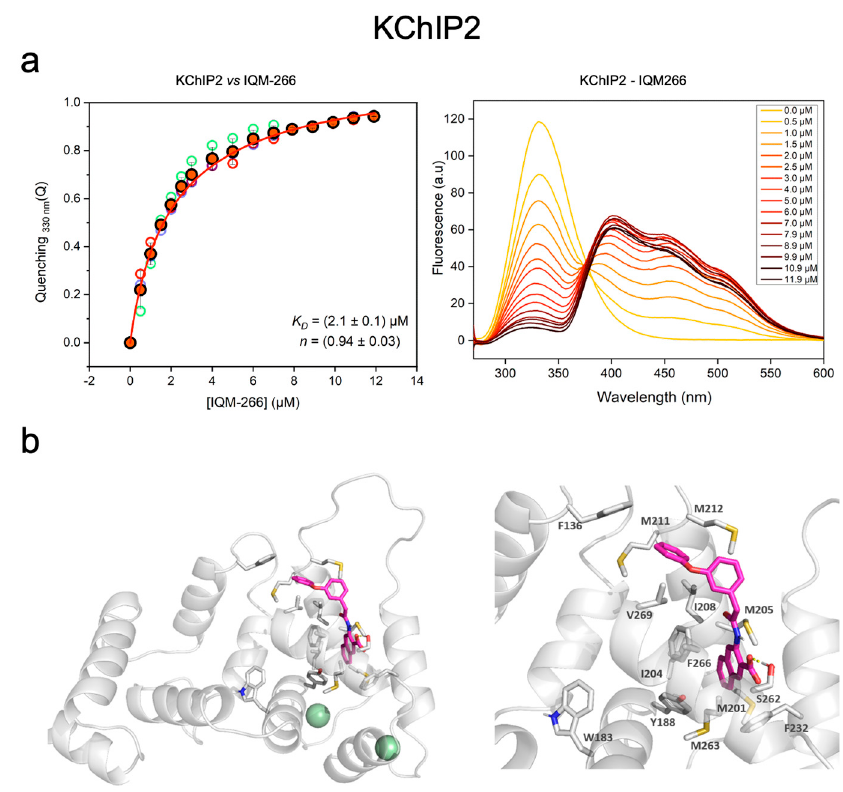
Figure 1. Concentration-dependent interaction between IQM-266 and KChIP2. ( a ) Interaction between IQM-266 and KChIP2. Left panel shows the plot of the quenching of tryptophan by FRET towards IQM-266. Data from the five repetitions (open symbols) are shown as well as the average value (red-filled symbols) and error bars as s.d. The red line represents the fit to a Hill equation. Right panel shows the fluorescence emission spectra ( λ ex = 260 nm) from a representative titration of KChIP2 (5 µM) with increasing concentrations of IQM-266. ( b ) Representation of IQM266 binding pose with the homology model of KChIP2. Residues within the binding pocket, together with Trp, are indicated. For clarity, only polar hydrogens are included and the hydrogen bond is depicted as a discontinuous yellow line (PyMOL Molecular Graphics System, Version 2.0 Schrödinger, LLC. New York, NY, USA).